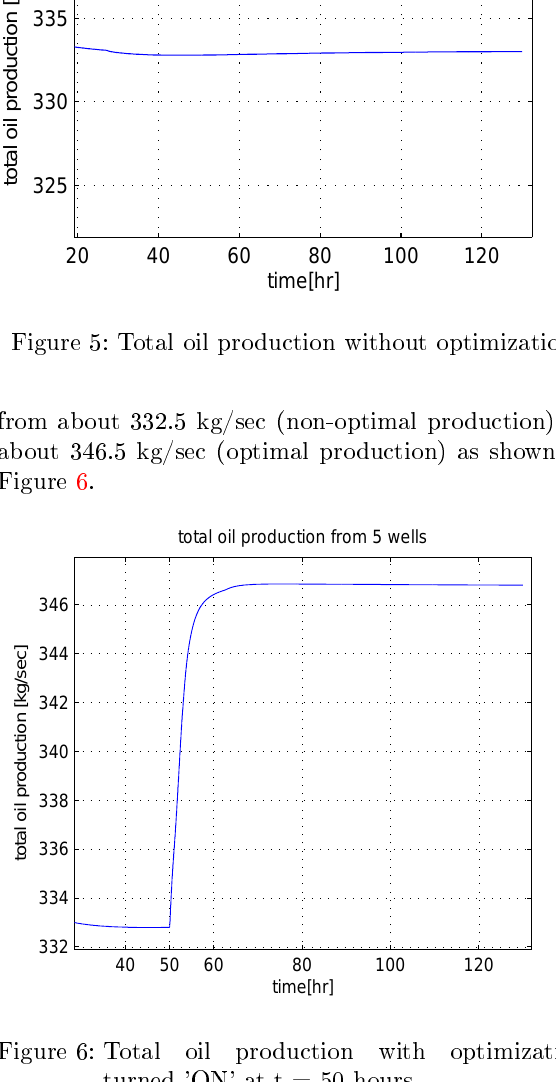
Figure 6: Total oil production with optimization turned ’ON’ at t = 50 hours The distribution of the lift gas through the choke valves without any optimization is shown in Figure